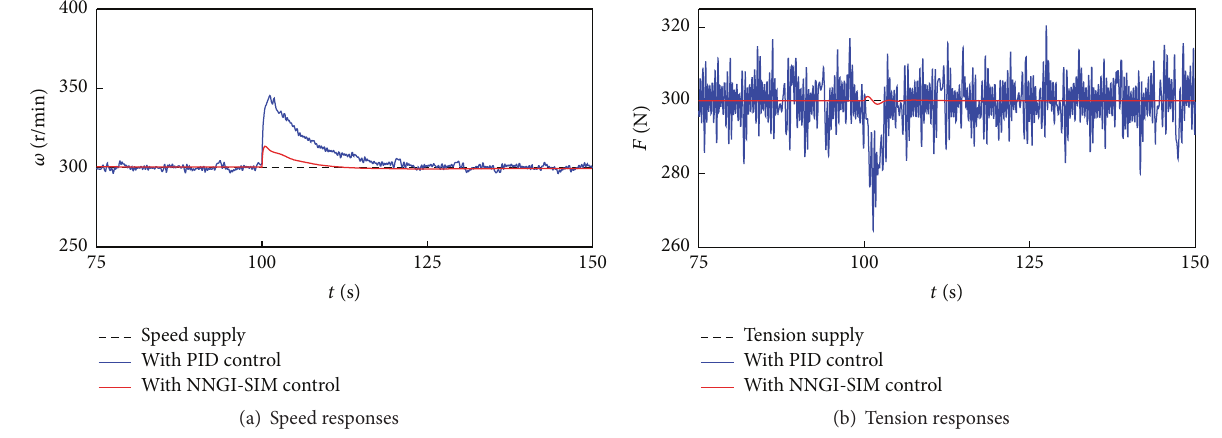
Figure 9: Simulated responses for sudden decreased load impact.